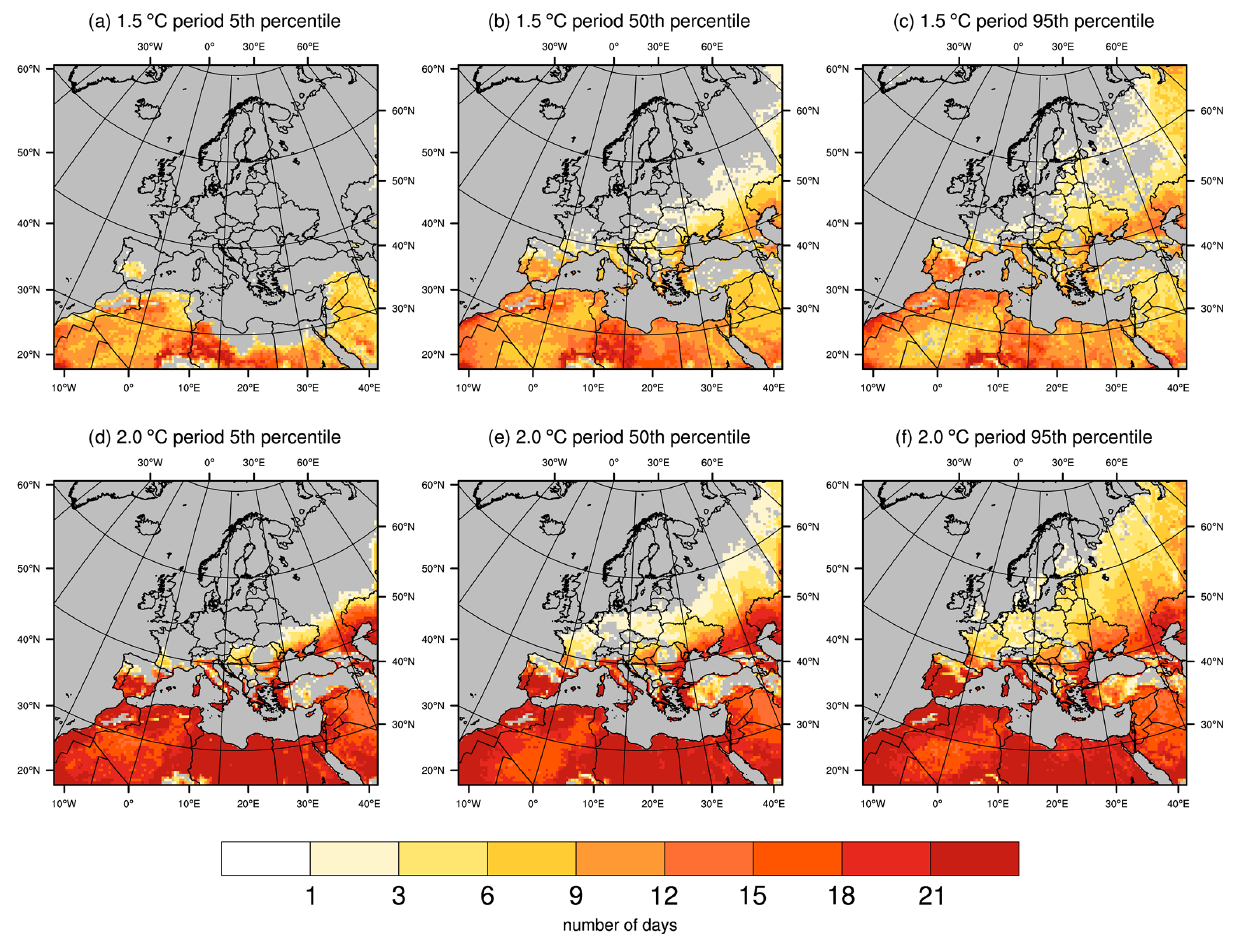
Figure 2. Differences in ATG28 between the current and the 1.5 ◦ C period and (a–c) the 2.0 ◦ C period (d–f) for the NorESM-driven REMO simulations in number of days. Shown are the differences in the 5th percentile (a, d) , median (b, e) and 95th percentile (c, f) . Differences over ocean areas are masked out in grey, as they are closely related to the prescribed SST changes. Masked-out areas over land refer to areas with fewer than 20 occurrences of ATG28 during the current